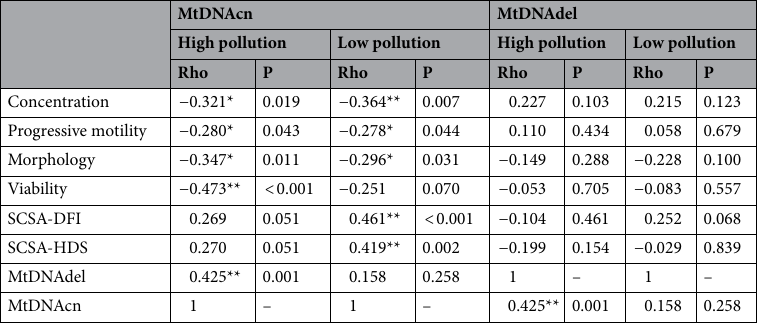
Table 2. Spearman’s correlation of mtDNAcn and mtDNAdel rate with semen parameters and sperm chromatin characteristics following periods of high and low air pollution, adjusted for age. **Correlation is significant at the 0.01 level. *Correlation is significant at the 0.05